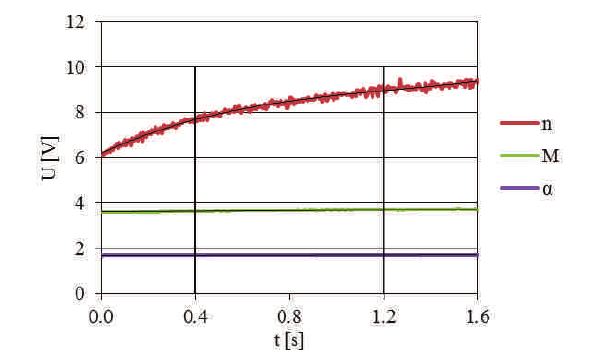
Fig. 3. Engine parameters in dynamic states